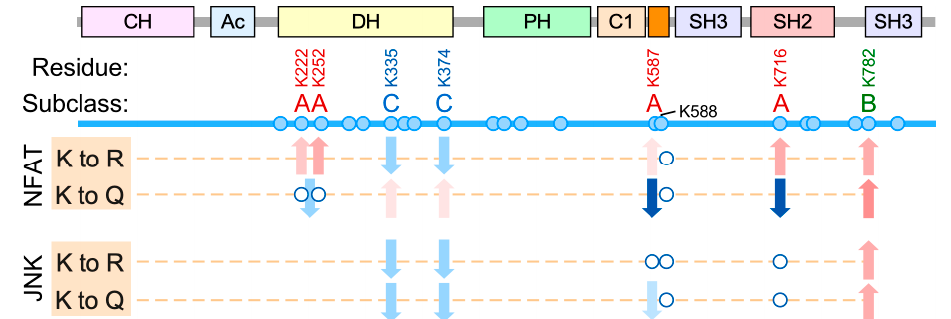
Figure 8. Summary of the results obtained in our work with the indicated deacetylation- and acetylation-mimetic Vav1 mutants. The residues selected for our study are shown on top. Subclass A, B, and C sites are shown in red, green, and blue, respectively. Sites with no detectable effect on Vav1 activity are shown in black. The biological assays and mutants used are indicated on the left. Red and blue arrows indicate increased and decreased stimulation of the indicated pathway, respectively, when compared to the activity of Vav1 WT . Empty circles indicate no statistically significant differences in activity when compared to Vav1 WT . When using a double mutant protein, the arrow is placed between the two circles.